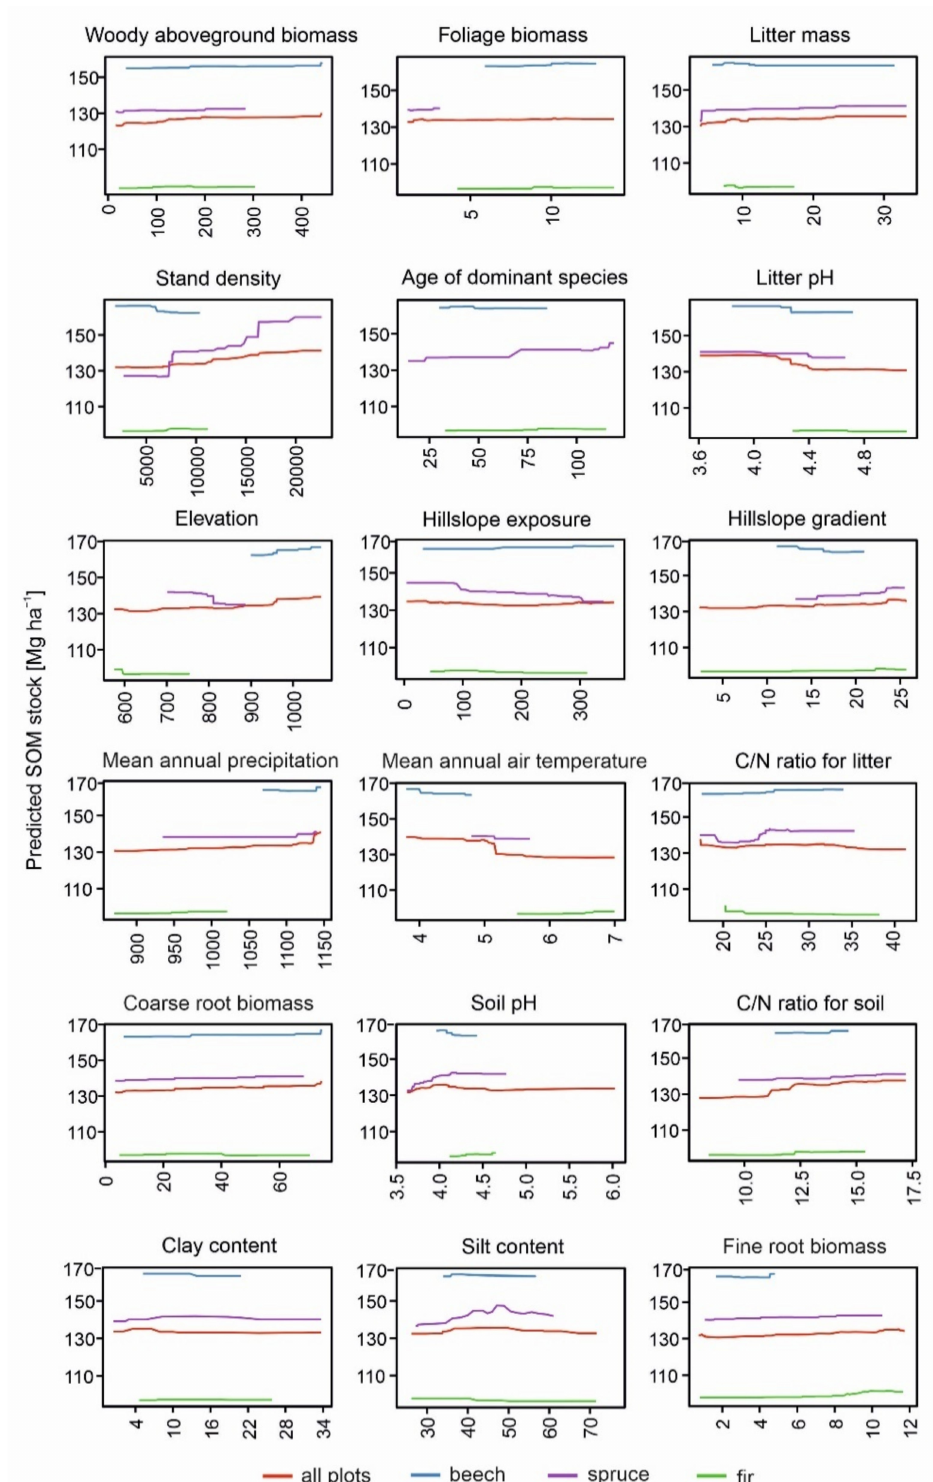
Figure 6. Partial dependence plots (pdp) showing average predictions of the SOM stock. Lines show average predictions for continuous predictors, assuming mean values of all remaining predictors. Abbreviations—see explanation in Table 2. Explanation of interpretation of pdp included in Section